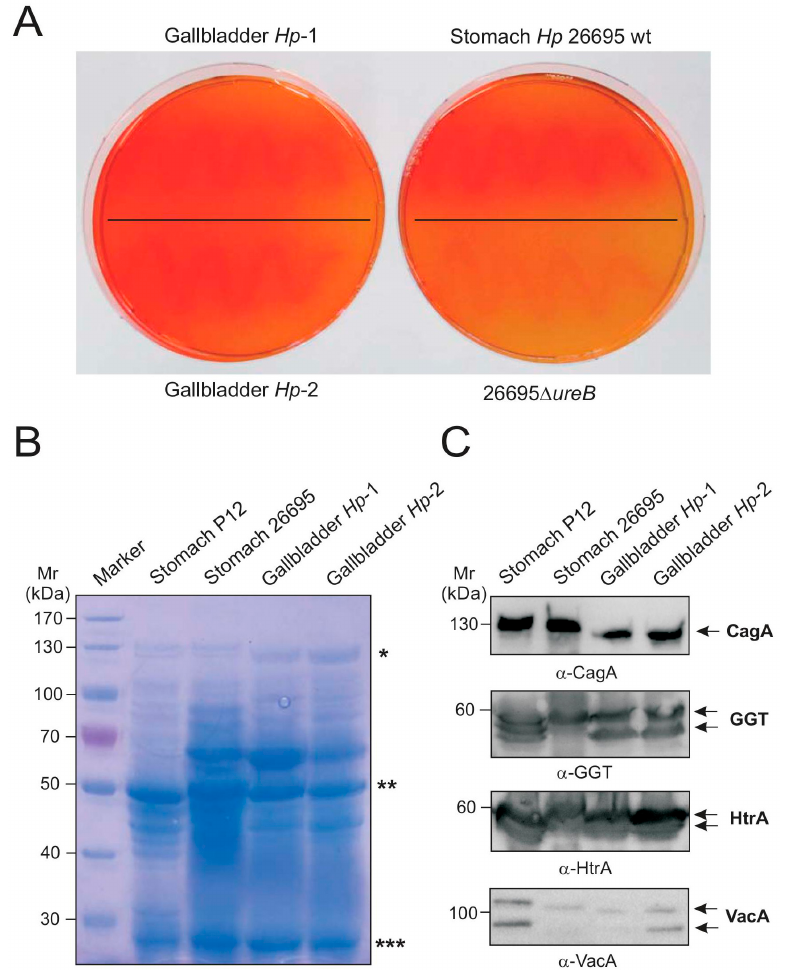
Figure 3. Urease test and Western blotting analysis of H. pylori -specific pathogenicity factors from gallbladder strains. ( A ) Two H. pylori isolates (Gallbladder Hp-1 and Hp-2 ) were grown on acidified agar supplemented with urea (left samples). The observed color change from orange to red indicated that bacterial colonies were producing functional urease. The right samples represent positive controls. The color change occurred with the wild-type (wt) strain 26695 as expected, and was not observed with the negative control of an isogenic Δ ureB deletion mutant, indicating that functional urease enzyme was not being produced; ( B ) Protein profiling using Coomassie staining. Asterisks label the following protein bands: CagA (*), Urease B (**), and Urease A (***); ( C ) Western blots of two reference strains (P12 and 26695) and the two gallbladder isolates that identifies presence of H. pylori proteins CagA, VacA, GGT and HtrA.